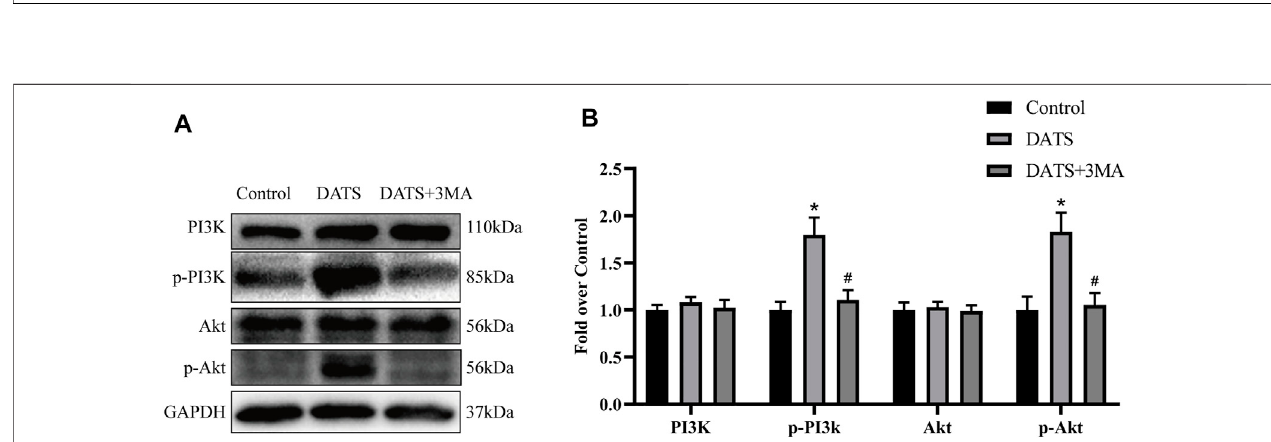
FIGURE7| DATSabatesapoptosis bythePI3K/Akt signaling pathway. (A) WesternblottingofPI3K/Akt signaling pathway markers, PI3K, p-PI3K, Akt, and p -Akt in the control, DATS, and DATS+3MA groups. All the gel electrophoresis experiments were carried out under the same experimental conditions. (B) Statistical chart of the quanti fi cation of PI3K, p-PI3K, Akt, and p -Akt expressions in the perforator fl aps. * p < 0.05, vs. control group; # p < 0.05, vs. DATS group. The obtained data were expressed as means ± SEM, n = 6 for every group. DATS, diallyl trisul fi de.